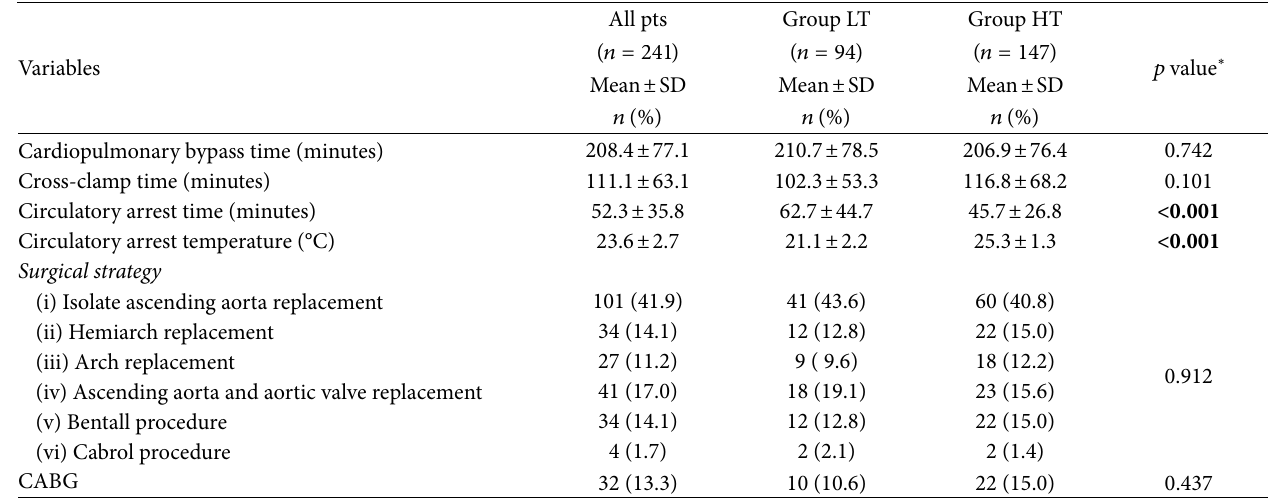
Table 2: Intraoperative